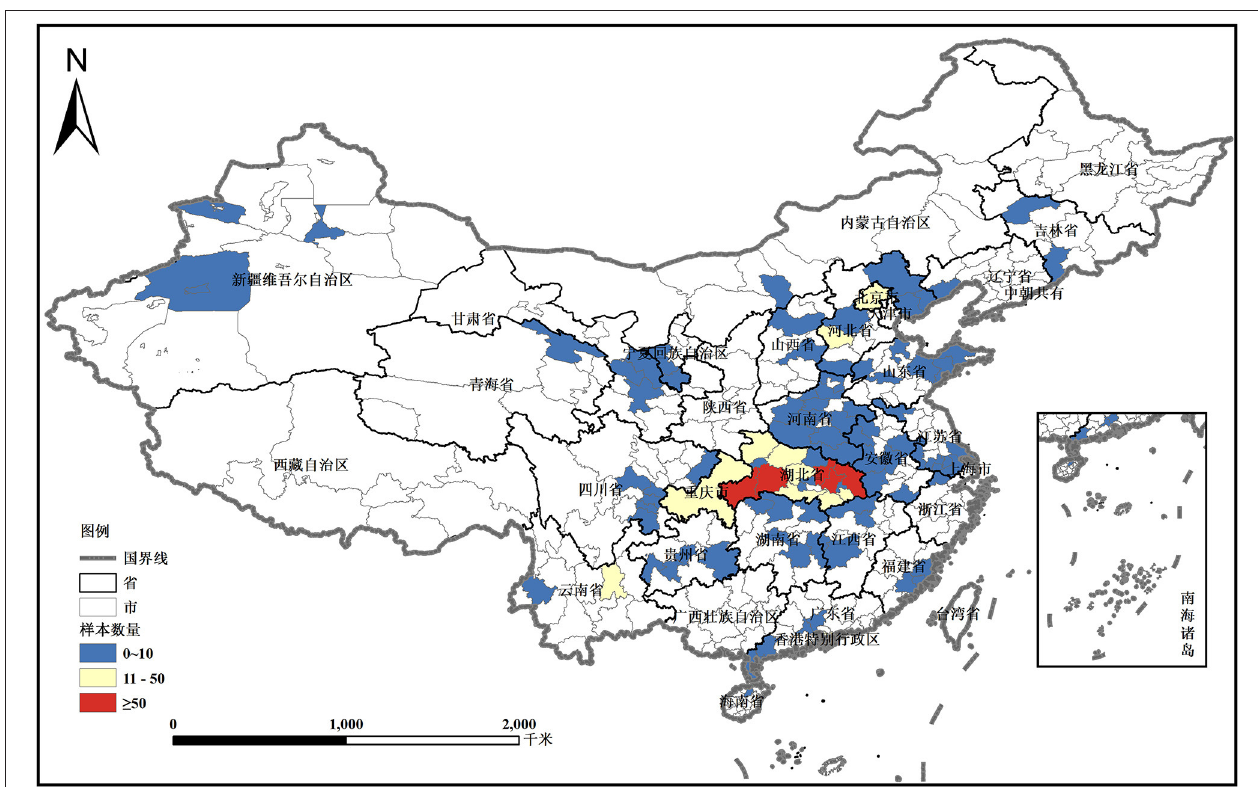
FIGURE 2 | The location of the surveyed areas and sample distribution.